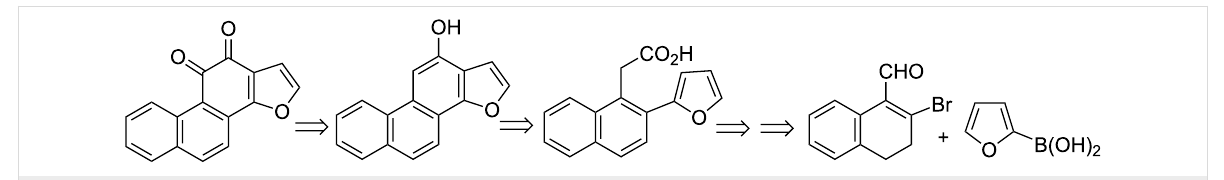
2-bromo-3,4-dihydro-1-naphthaldehyde (a substrate